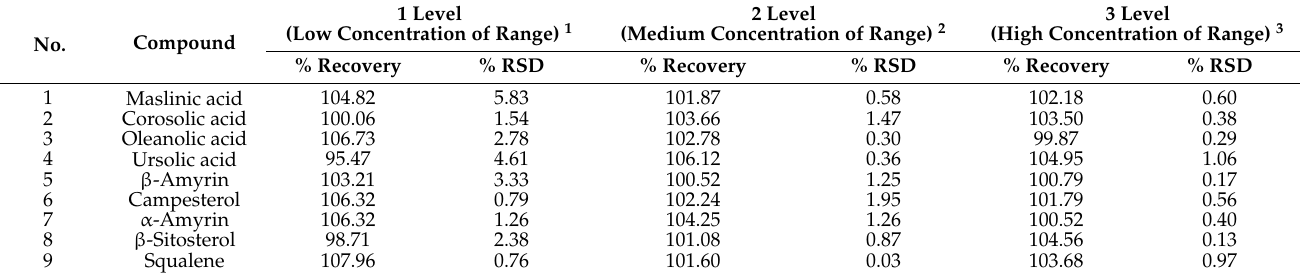
Table 2. Determination of the recovery of the identified